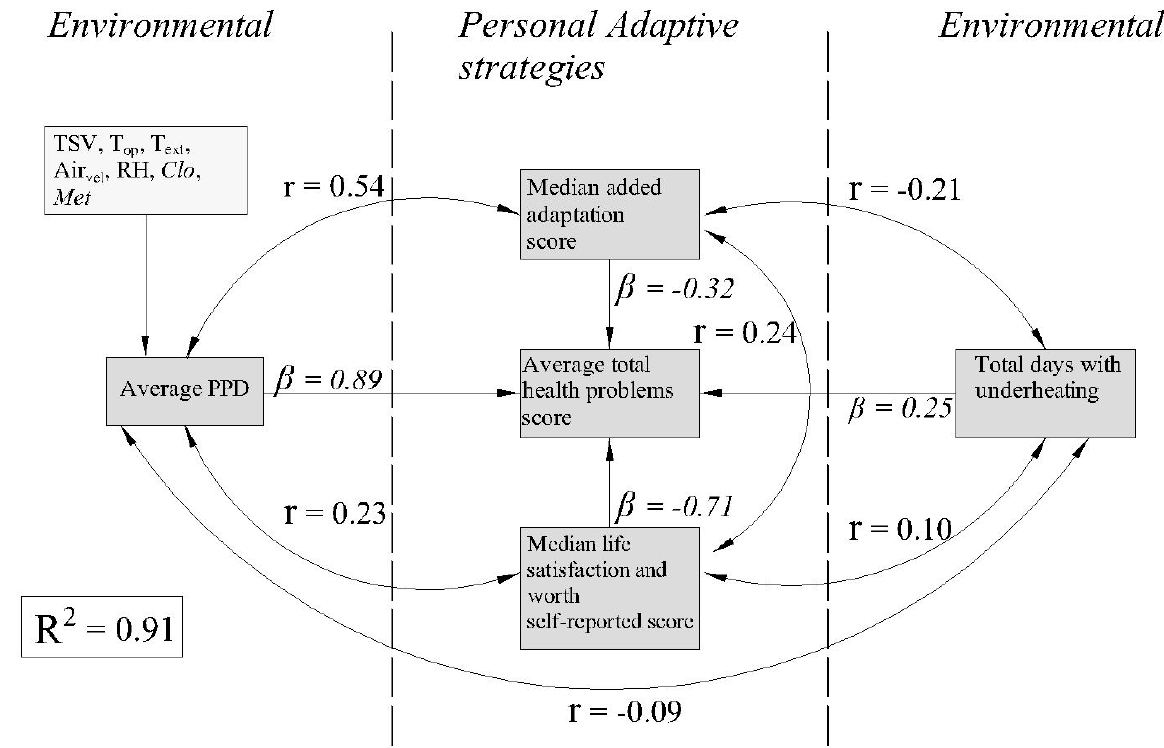
Figure 14. Relationships among predictors of average total self-reported health score in the best-fit multiple linear regression model (backward method; R 2 = 0.91; Adjusted R 2 = 0.88); distinguished by whether predictors are of the environmental origin or personal adaptive strategies. Direct effects are displayed by straight arrows, whereas correlations among predictors are described as curved arrows. Variables composing the PPD index are pictured within a lighter-shaded box (upper-left corner) for informative purposes only.